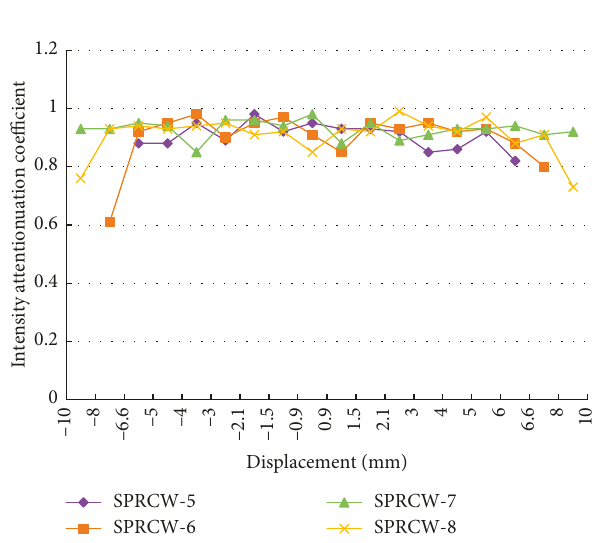
Figure 16: Intensity attenuation curve of test pieces. Table 7: The shear bearing capacity comparison of